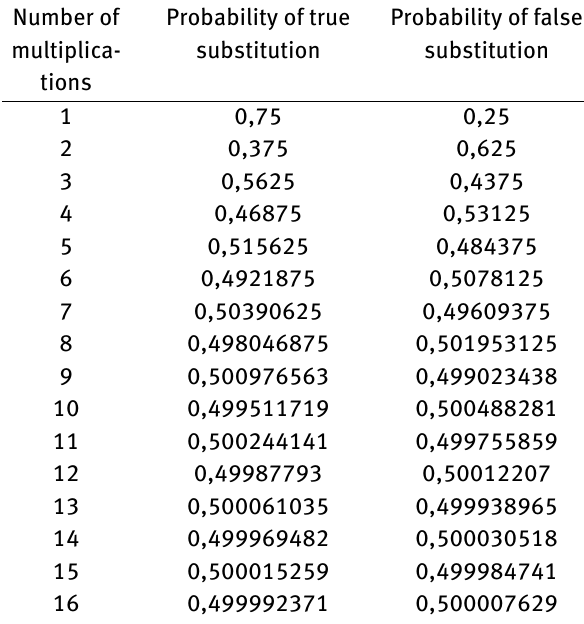
Table 5: Probability of trueness versus the number of multiplica- tions in equation Number of Probability of multiplica- tions